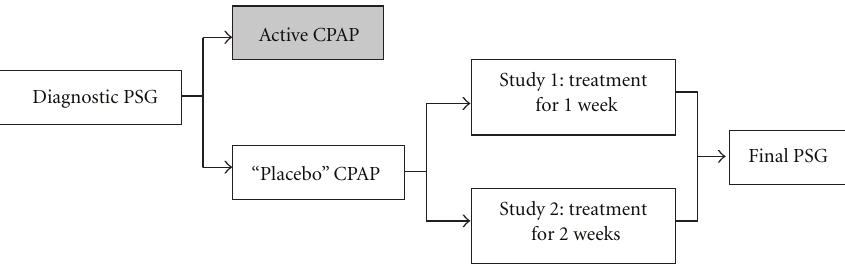
Figure 1: Diagram of study design ∗ .